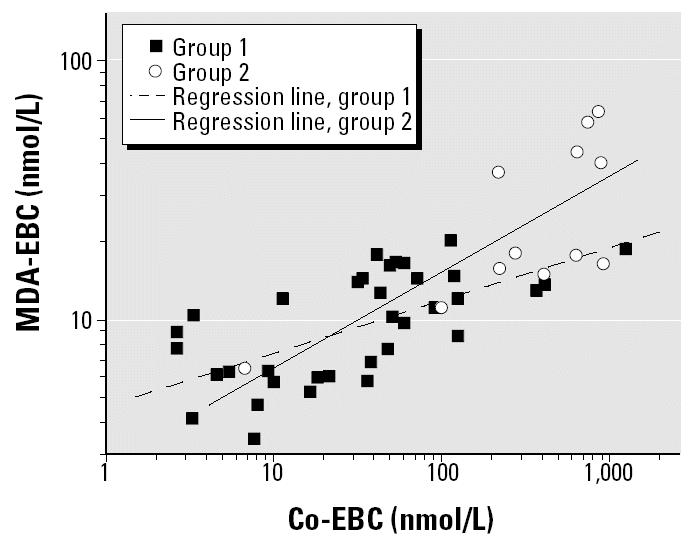
Correlation between Co-EBC and MDA-EBC levels. Group 1, workers with W-EBC < 16.3 nmol/L [log(MDA-EBC) = 0.66 + log(Co-EBC0.21)]; group 2, workers with W-EBC > 16.3 nmol/L [log(MDA-EBC) = 0.44 + log(Co-EBC0.37)].